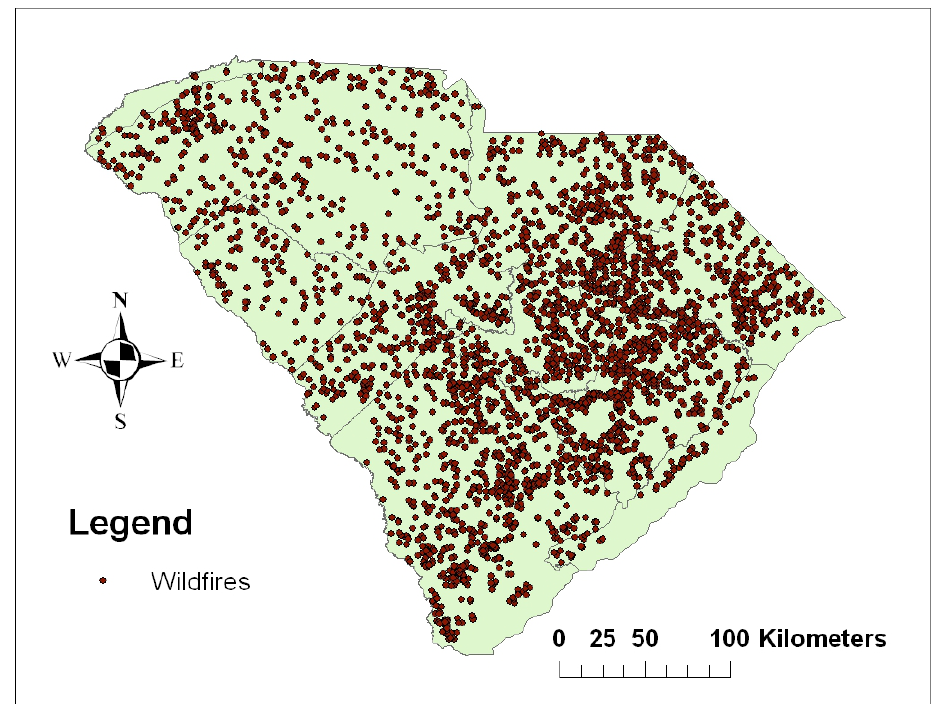
Figure 2. Wildfires for everyday having seventy or more wildfire